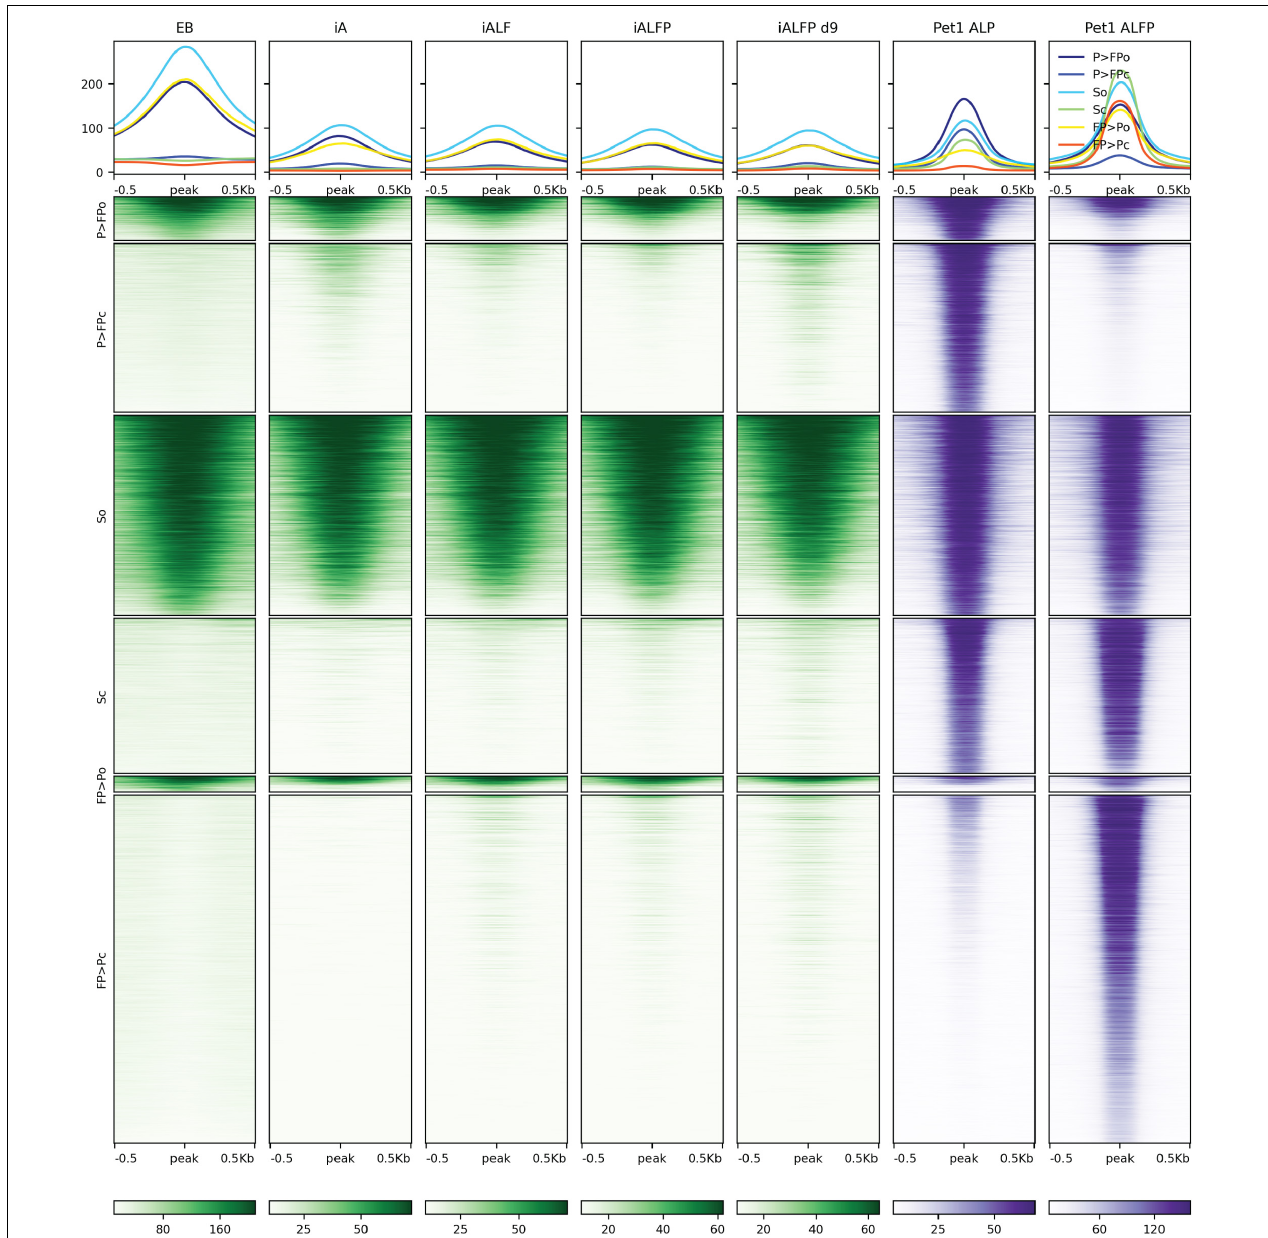
FIGURE 6 | Comparison of ATAC-seq profiles with iALFiP Foxa2 and Pet1 binding categories. ATAC-seq heatmaps plot EB, iA (48 h), iALF (48 h), iALFiP (48 h), and iALFiP (d9) ATAC-seq signals over the iALP and iALFiP Pet1 binding categories displayed in Figure 4B . Each Pet1 binding category is first split into two groups according to overlap with ATAC-seq domains in the preexisting EB cell state. Thus, six categories of sites are plotted. Panels above heatmaps display average ATAC-seq or ChIP-seq signals in each of the six categories. The color scaling in all heatmaps vary between the read counts observed in the 10th and 90th percentiles of